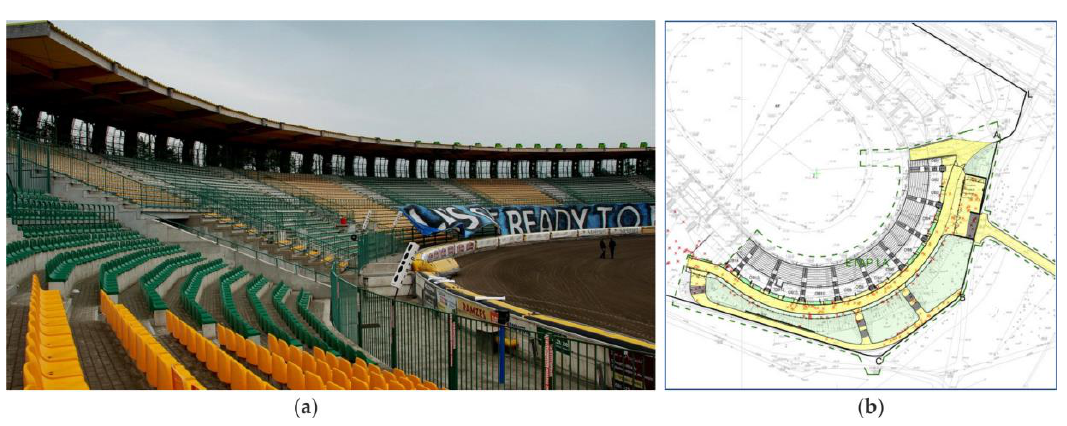
Figure 2. Swiss Krono Arena: ( a ) the view on the grandstand, ( b ) the location of the grandstand on the land development plan .